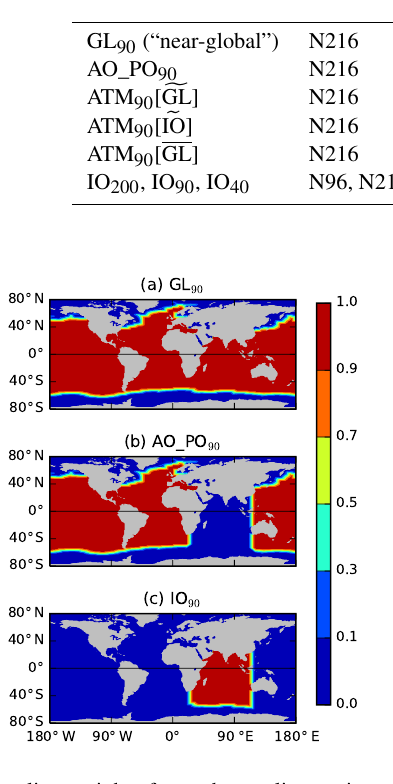
Figure 1. Coupling weights for each coupling region used in the experiments: (a) GL 90 ; (b) AO_PO 90 ; (c) IO 90 . The MC-KPP SST is multiplied by the weight shown and the prescribed SST by (1 − weight), and the sum of the two is the boundary condition to the atmospheric grid box. A 10 ◦ width (12 grid points) blending is applied at any boundary that is not a coastline. The weights for 200km and 40km experiments are the same but with 5- and 30- point blending,